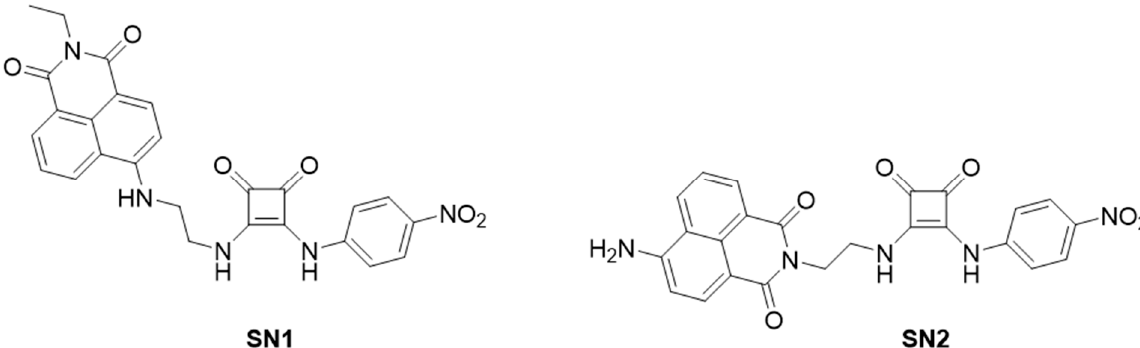
Figure 1. Chemical structures of probes SN1 and SN2 .